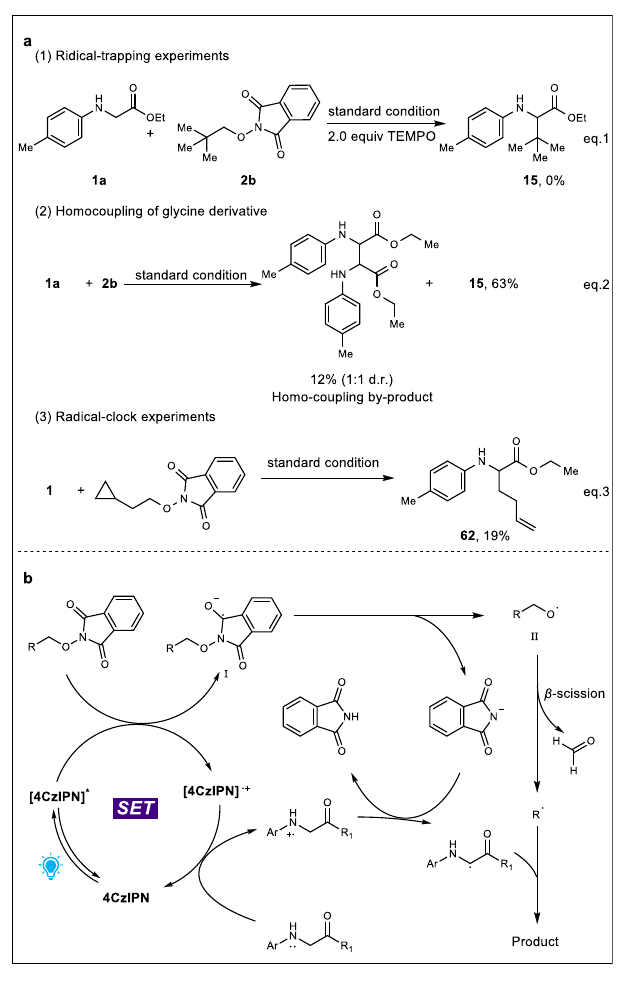
Fig. 7 | Mechanistic studies. a Control experiments; b Proposed